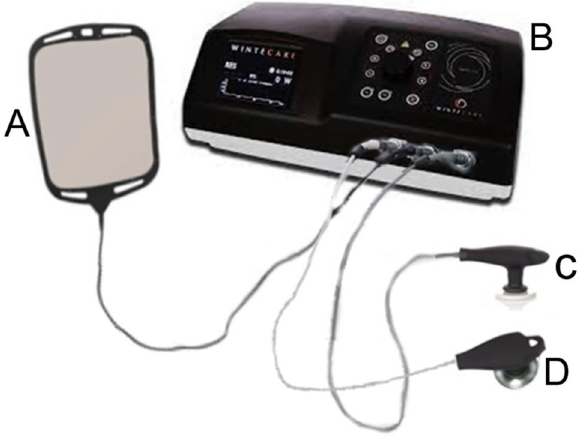
Figure 1. Schematic of the CRet device. (A) Return electrode (base plate); (B) T-Plus Control Center; (C) capacitive electrode; (D) resistive